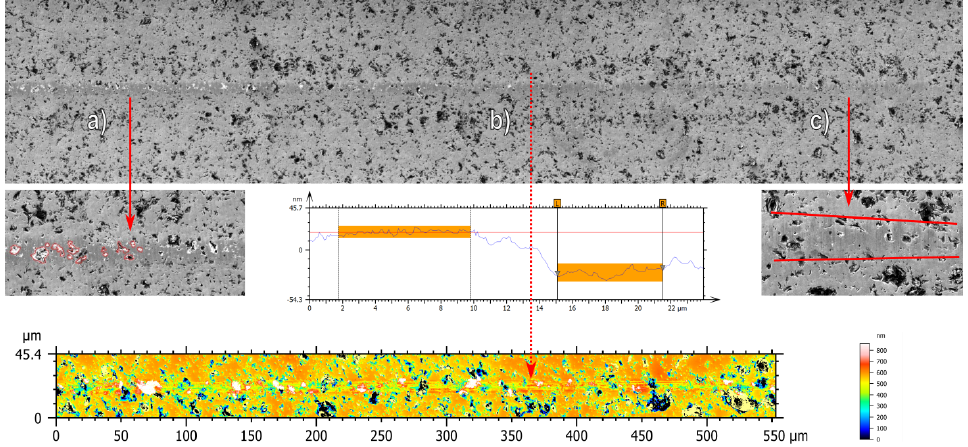
Figure 14. SEM and CLSM micrographs showing the determination of the brittle ( a ) to ductile ( c ) transition depth ( b